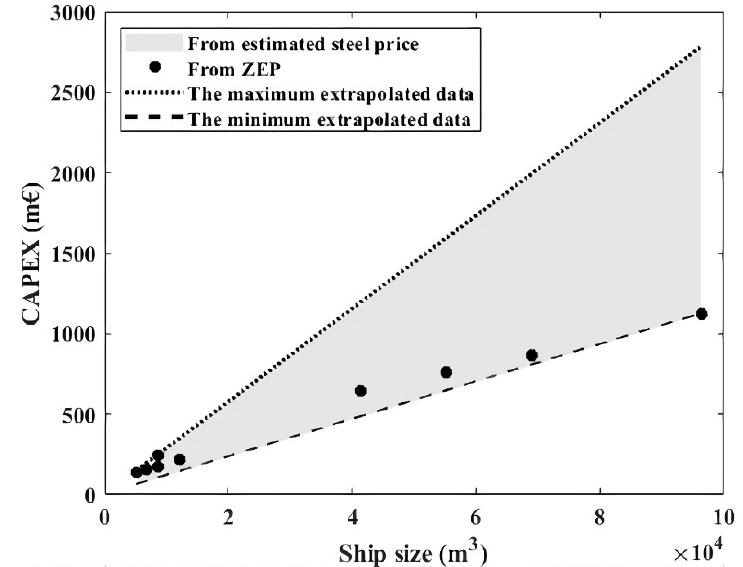
Figure 6. Recalculation crewed ship CAPEX in comparison with ZEP results [21]. Table 14. Crewed/autonomous tanker ship CAPEX inputs.